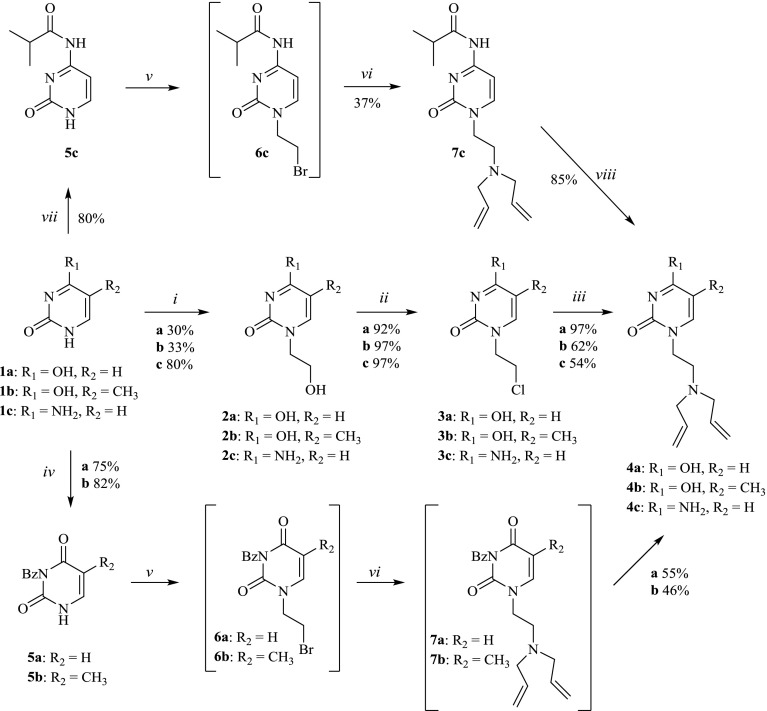
Synthesis of compounds 4a, 4b & 4c. Reagents and Conditions: (i) Ethylene carbonate, NaOH, DMF, reflux, 24 h; (ii) SOCl2, dry pyridine, dry dioxane, reflux, 2 h; (iii) diallylamine, absolute EtOH, reflux, 3 d; (iv) a. Benzoyl chloride, pyridine, acetonitrile, r.t., 4 d b. K2CO3, dioxane; (v) DIAD, Ph3P, BrCH2CH2OH, dry dioxane, r.t., 24 h; (vi) diallylamine, dry dioxane, reflux, 2–5 d; (vii) Isobutyric anhydride, dry DMF, reflux, 2 h; (viii) NaOMe, MeOH, reflux, 3.5 h then r.t., 24 h.